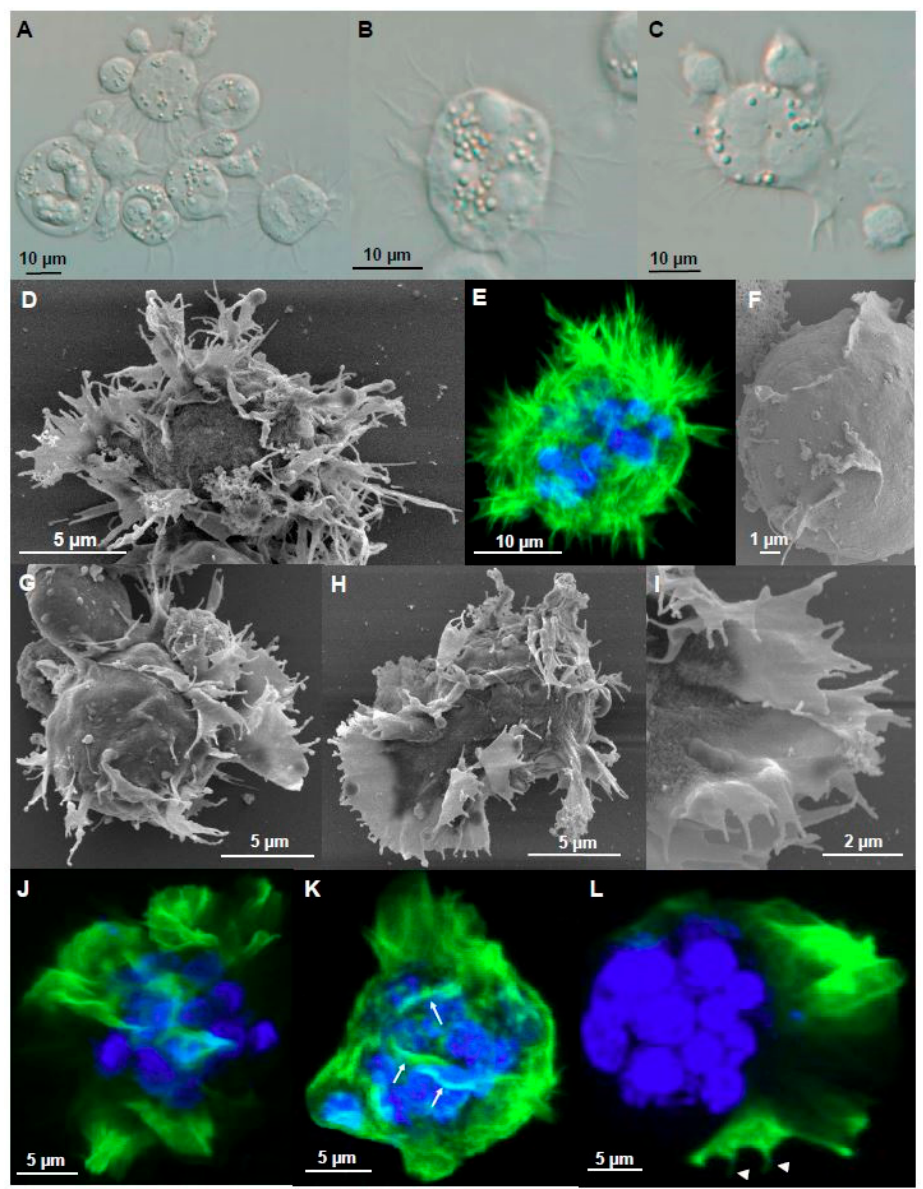
Figure 3. Filopodia and lamellipodia of adhesive stages of Ceratonova shasta genotype IIR in rainbow trout. ( A ) Presporogonic and sporogonic developmental stages showing abundant static filopodia. ( B ) Radially distributed filopodia on a stage. ( C ) Sheet-like lamellipodia with filopodia on the lamellipodia border and also all over the body of the stage. ( D ) 3D radiating pattern of filopodia. ( E ) F-actin distribution on a 3D radiating pattern of filopodia. ( F ) Detail of the parasite surface with small crests. ( G , H ) Parasite stages with sheet-like lamellipodia and small filopodia projecting in the external margin. Notice the sheet-like lamellipodia located on one side, with opposing single and ramified filopodia over the rest of the parasite body. ( I ) Detail external margin of lamellipodia with small filopodia on the external border. ( J – L ) F-actin distribution on stages with lamellipodia. ( K ) Stage showing F-actin rich small crests (arrows) on the surface. ( L ) Small F-actin rich filopodia (head arrows) on the external margin of the lamellipodia. All stages were collected from ascites. A – C Light microscopy, D , F – I SEM, E , J – L CLSM (Green-F-actin, phalloidin; blue-nucleic acids,